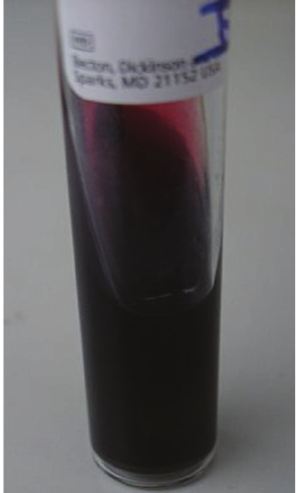
Figure 3: Triple sugar iron (TSI) slant. Hydrogen sulfide production is typically seen with Salmonella spp. and serves as a diagnostic